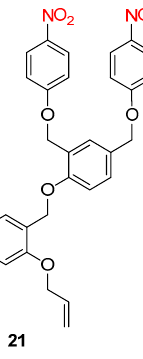
Figure 3. Dendrimer 21 resulting in dendritic amplification.